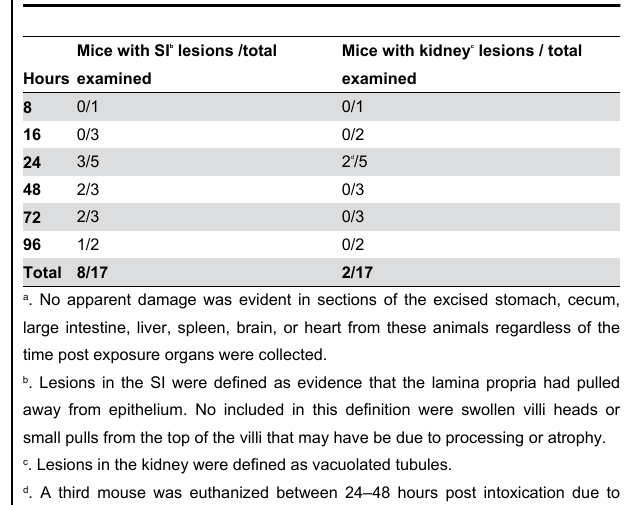
Table 3. Proportion Of Mice That Showed Pathological Changes In The Small Intestine- (SI) And/Or Kidneys a At Various Time Points